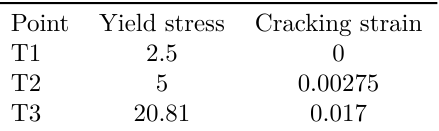
plate is constrained in the vertical direction on the bottom face and a vertical displacement δ is im- posed on the loading line. The mesh is shown in the same figure: eight-node linear hexahedral elements (C3D8R - Continuum, 3-D, 8-node - reduced integra- tion) are used.